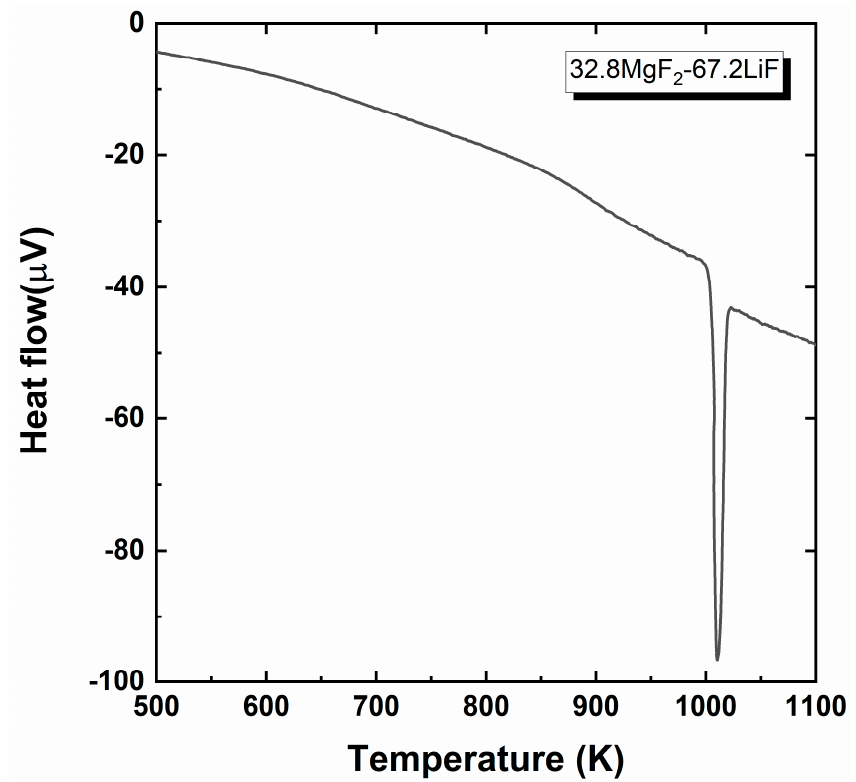
Figure 2. Differential thermal analysis (DTA) thermal curve of the 32.8MgF2–67.2LiF system. Figure 2. Di ff erential thermal analysis (DTA) thermal curve of the 32.8MgF2–67.2LiF system. Metals 2020 , 10 , x FOR PEER REVIEW